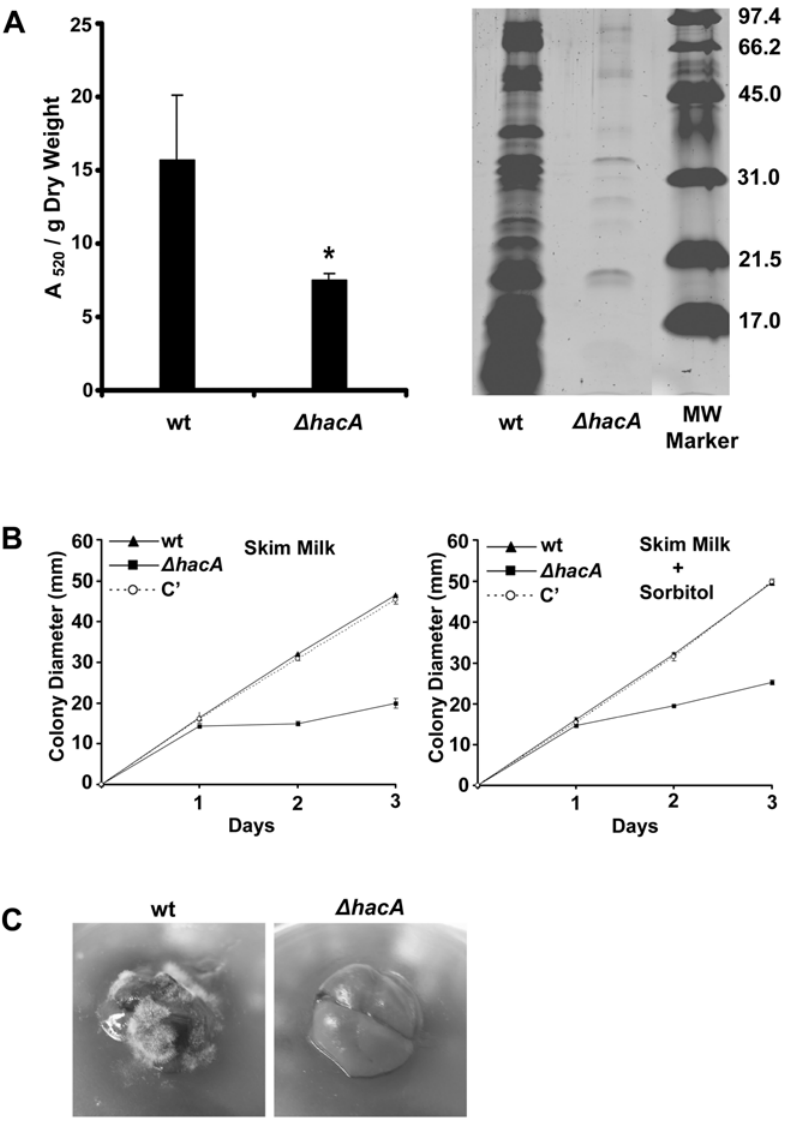
Figure 9. The UPR supports protease secretion and growth on complex substrates. (A) Azocoll hydrolysis by A. fumigatus proteases: Equal numbers of conidia were inoculated in liquid AMM-FBS, and incubated at 37 u C/150 rpm for 72 h. Culture supernatants were incubated in the presence of Azocoll for 3 h and the absorbance of the medium at 520 nm was determined. The experiment was performed in triplicate and values represent the mean A 520 /g dry weight 6 SD. Significance was assessed using a two-tailed t-test, and the asterisk indicates that the Azocoll hydrolysis is significantly less in the D hacA mutant than in the wt (p , 0.05). 1D gel analysis of wt and D hacA secreted proteins: Equal numbers of wt and D hacA conidia were inoculated into liquid AMM and incubated for 3 days at 37 u C without shaking. The hyphal mat was removed, and the supernatant was concentrated as described in Materials and Methods. A 5 m l aliquot of each sample was then fractionated by 1D SDS-PAGE and proteins were stained by SYPRO Ruby dye. The protein marker is shown in kD. (B) Growth on skim milk: Conidia were spotted onto skim milk agarose plates in the presence or absence of 1.2 M sorbitol and colony diameter was monitored daily at 37 u C. The experiment was performed twice, with similar results. (C) Growth on mouse lung tissue: A freshly isolated piece of mouse lung tissue was inoculated with wt or D hacA conidia and incubated at 37 u C for 24 h. Experiments in Figure 7 were repeated with similar results.